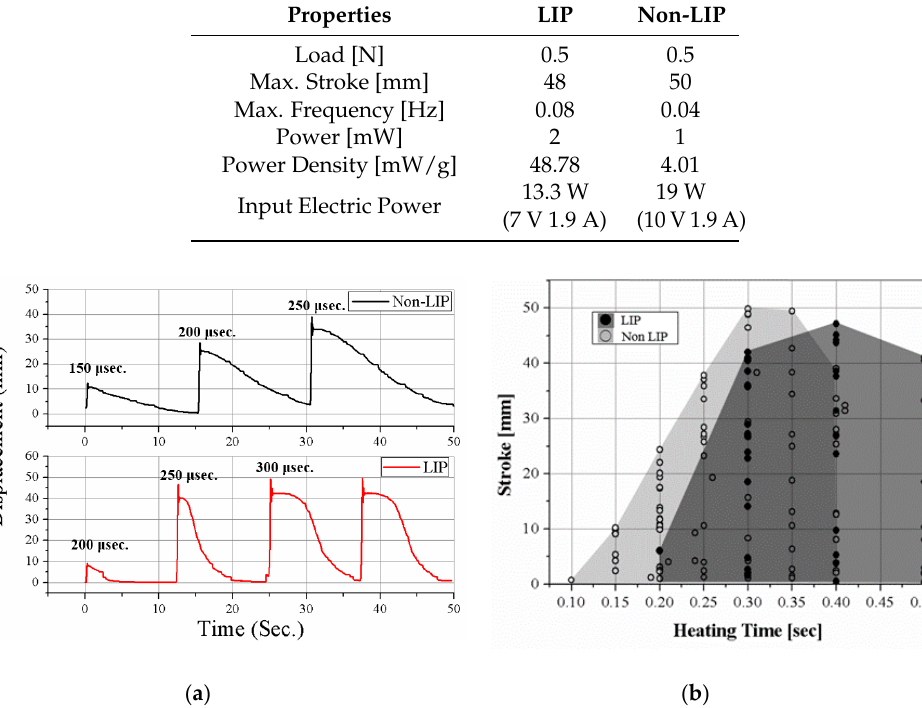
Figure 8. Cyclic actuation results for various heating times: ( a ) time–displacement responses for increasing heating time; ( b ) actuation stroke results depending on heating time.